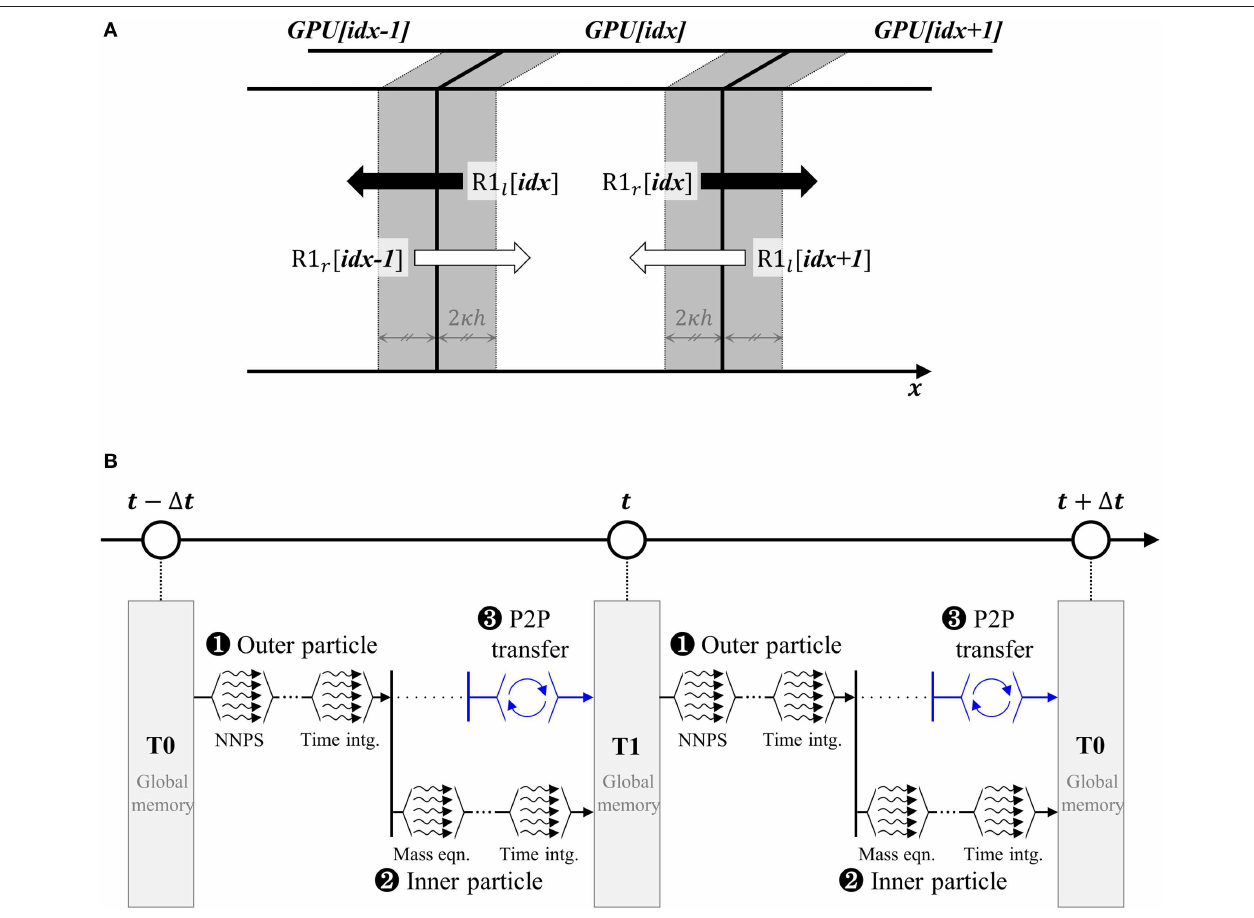
FIGURE 6 | Schematic process of the inter-GPU communication step: (A) concept of inter-GPU communication and (B) multi-stream scheme with time marching.